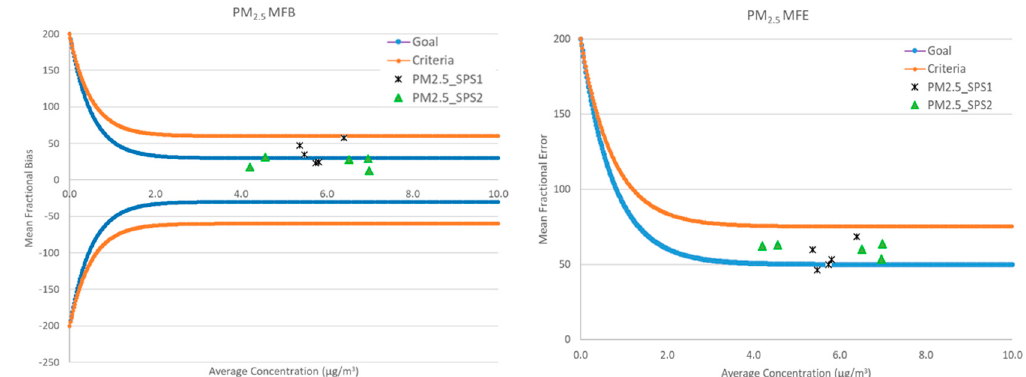
Figure 5. Bugle plots of ( a ) mean fractional bias (MFB) and ( b ) mean fractional error (MFE) for PM 2.5 for all predicted/observed pairs values at Chullora, Earlwood, Richmond, Liverpool and Wollongong stations for SPS1 (black star) and SPS2 (green triangle).